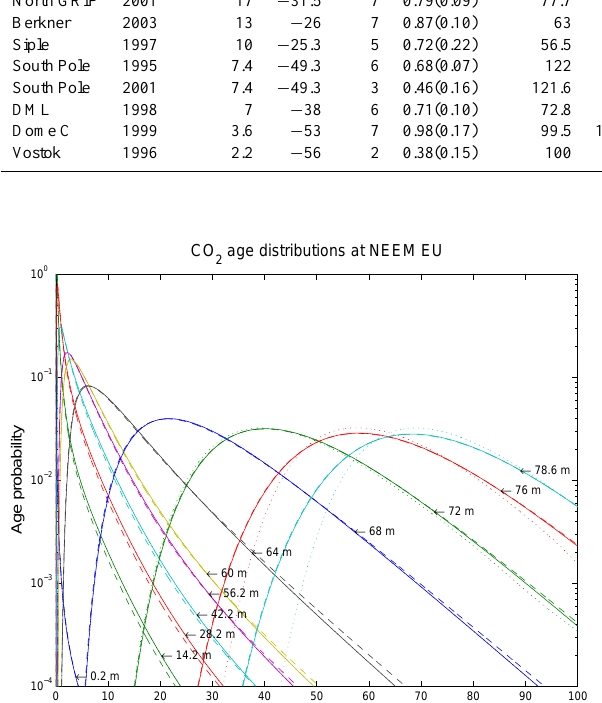
Fig. 7. Contribution of air of different ages at given depths (impulse response of the forward model for CO 2 at NEEM EU hole) using the optimal reference diffusivity ( case 4, “–”), without eddy dif- fusivity ( case 1, “- - -”), and with eddy diffusivity, but cancelling the diffusivity when D < 0 . 05m 2 yr − 1 (“ ···